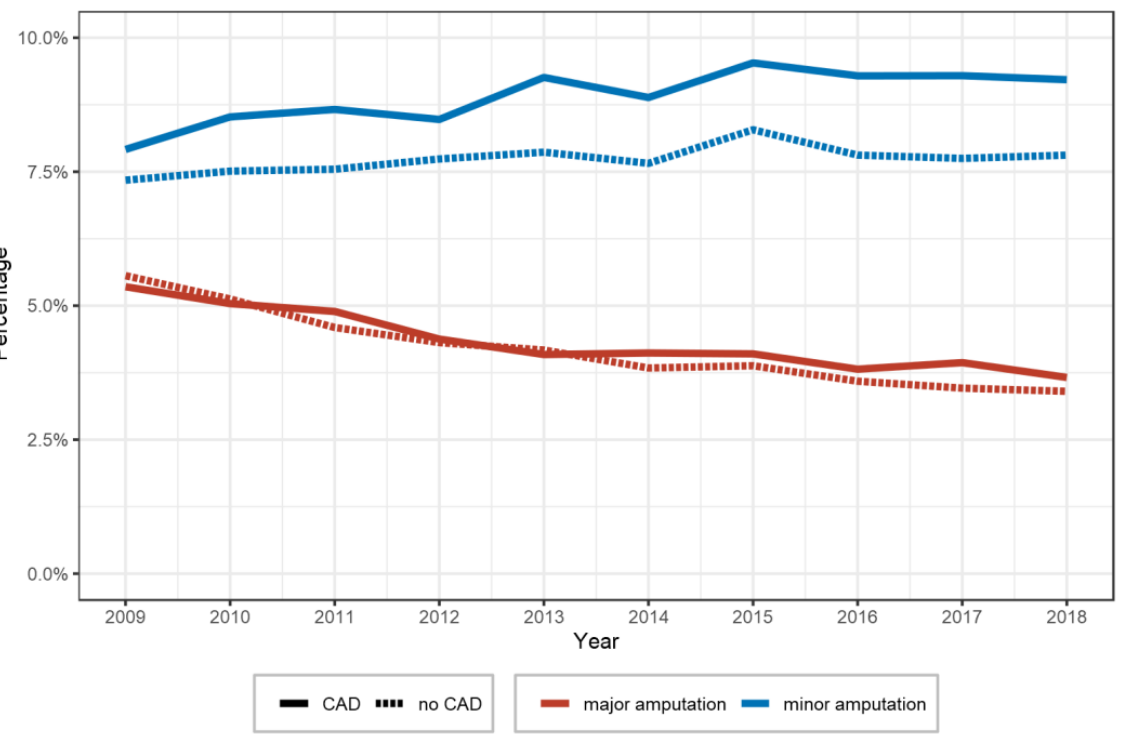
1.1 Data are presented as number (percentage). PAD: peripheral artery disease; CAD: coronary artery